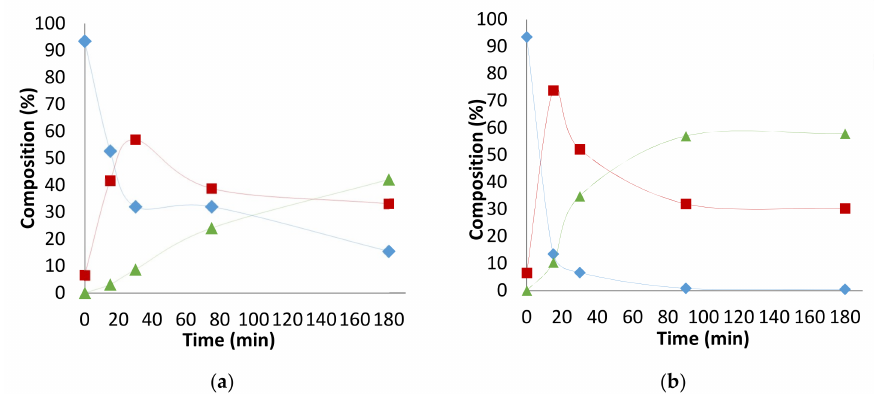
Figure A7. Composition profiles as a function of time with Rh- L2 system at [ 1 ] 0 /[Rh] = 3000: ( a ) toluene; ( b ) acetonitrile ( (cid:7) 1 , (cid:4) 1- int -x , (cid:78) 2 + 3 ) (conditions : 1 / 1- int -x (93.5:6.5) = 3.15 mmol, [ 1 ] 0 = 0.4 M,